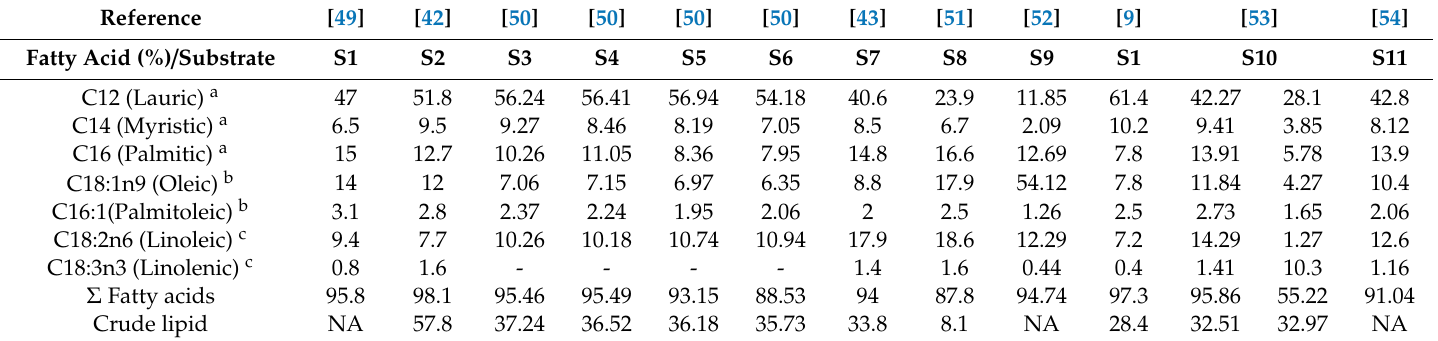
Table 1. Fatty acid distribution in BSFL reared on di ff erent